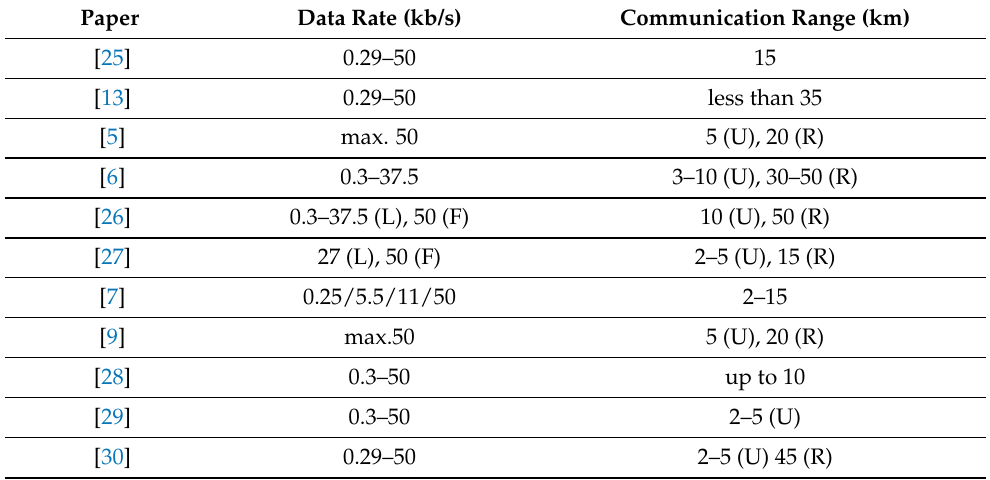
Table 1. Comparison of different parameter estimations based on the physical level in selected